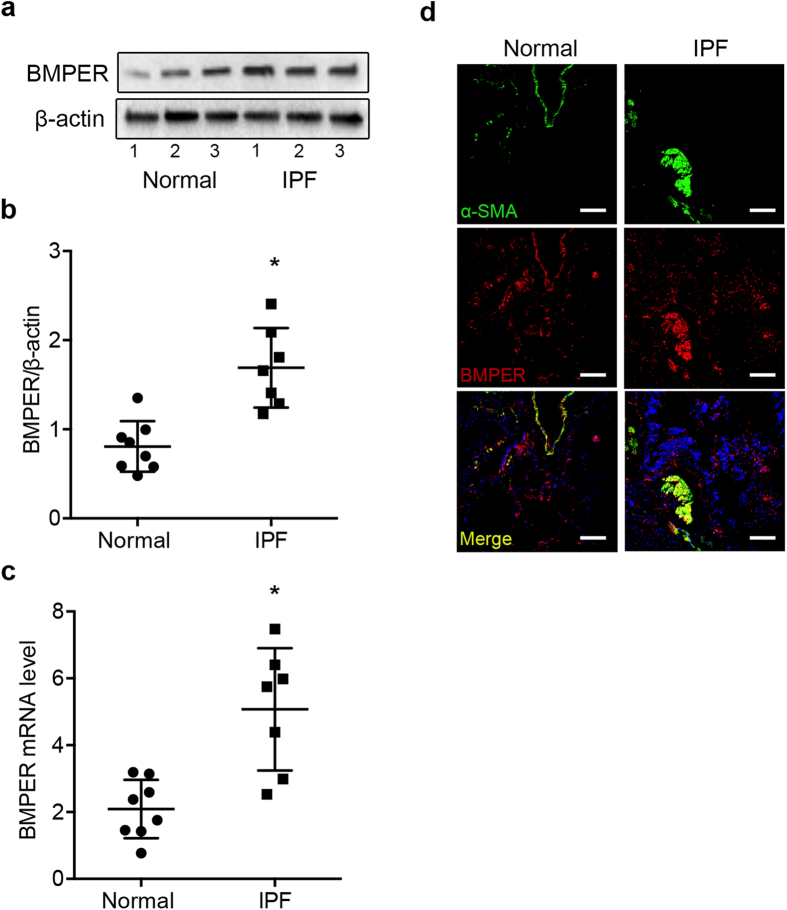
Increased BMPER expression in IPF lung fibroblasts and tissues.(a,b) BMPER protein levels were compared in primary lung fibroblasts derived from normal subjects and IPF patients with Western blot analysis (3 samples are shown). β-actin was used as a loading control. (b) Quantification of BMPER protein levels normalized to β-actin in normal and IPF lung fibroblasts by densitometry analysis (normal n = 8 and IPF n = 7; *P < 0.05, data are mean and SEM, unpaired t test). (c) BMPER mRNA expression was compared in primary lung fibroblasts derived from normal subjects and IPF patients with qRT-PCR analysis (normal n = 8 and IPF n = 7, *P < 0.05, data are mean and SEM, unpaired t test). GAPDH was used as an internal control. (d) BMPER was co-localized with α-SMA in fibrotic foci. Representative confocal photomicrographs of immunofluorescence labeling for α-SMA (green), BMPER (red) and merged (yellow) images were from normal subjects and IPF patients. Scale bars, 20 μm. The experiments were repeated three times. The full size blots were shown in the Supplementary Fig. S1.